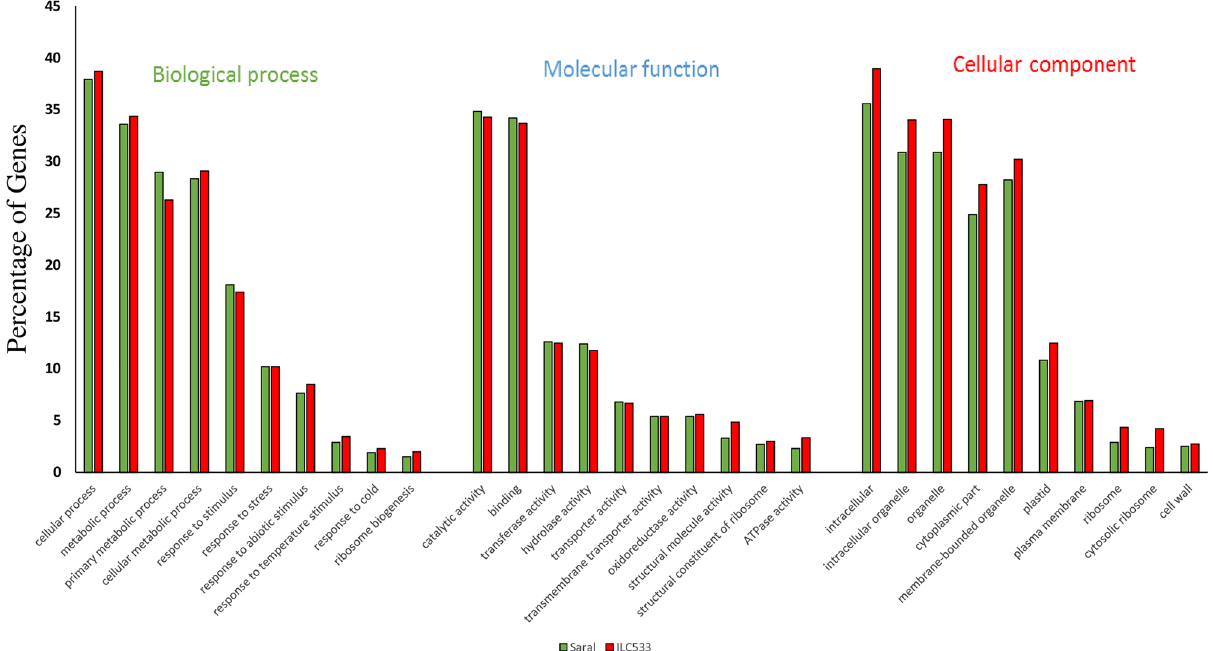
Figure 2. GO categorization of the DEGs in Saral and ILC533